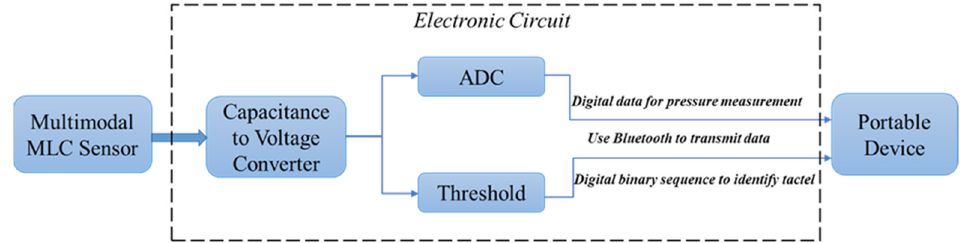
Figure 11. The proposed portable wireless system setup for future development for applications as wearables or as a commercial